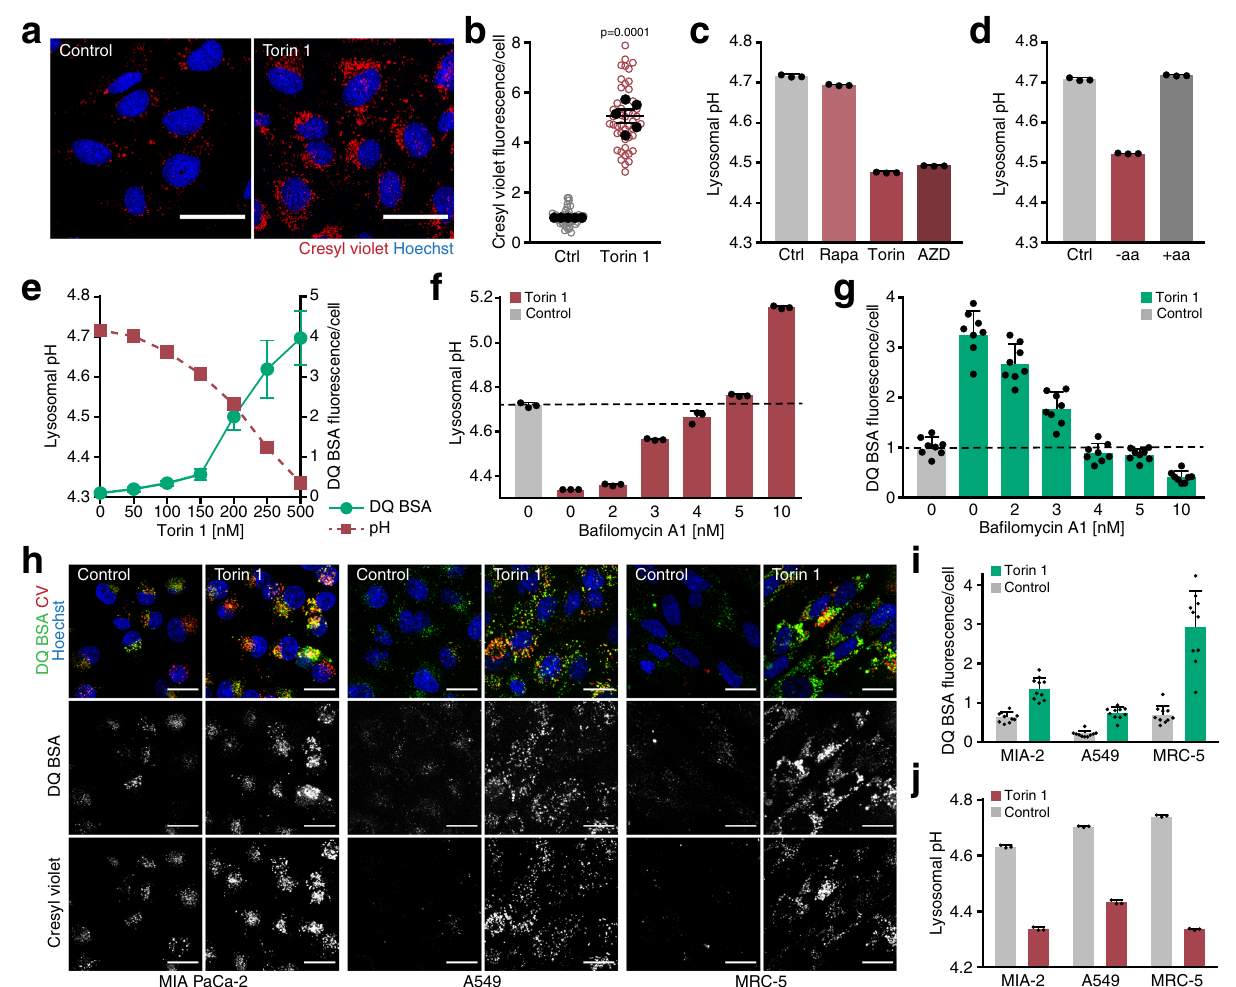
Fig. 2 | mTORC1 inactivation increases lysosomal protein catabolism through lysosomal acidi fi cation. a Cresyl violet accumulation in MEFs after 1h±torin 1 [400nM].Scalebars=50 µ m. b Quanti fi cationofcresylvioletaccumulationincells treatedasin a ;dataarenormalizedreplicatemean±SEM(closedcircles)and fi elds ofview(opencircles; ≥ 8perreplicate). c LysosomalpHofMEFsafter1hrapamycin [100nM], torin 1 [250nM], or AZD8055 [250nM], quanti fi ed by lysosensor. d Lysosomal pH of MEFs after 1h amino acid starvation ( − aa), or 1h aa starva- tion+30min aa restimulation (+aa), quanti fi ed by lysosensor. e Lysosomal pH, quanti fi ed by lysosensor, and degradation of lysosomally preloaded DQ BSA in MEFs after 1h torin 1 at indicated concentrations. Measurements were conducted separately under identical conditions. f LysosomalpH, quanti fi ed by lysosensor,in MEFsafter1htorin1[400nM]andba fi lomycinA1atindicatedconcentrations.The